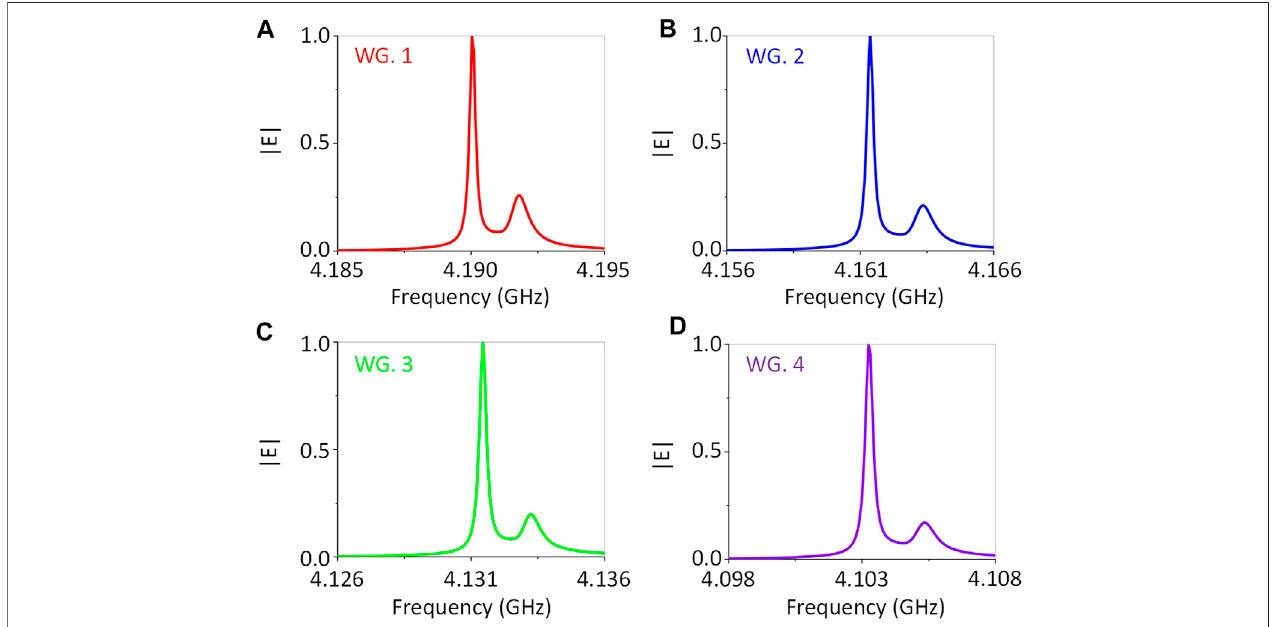
FIGURE 6 | Normalized electric fi eld intensity in the four types of waveguide segments at different frequencies. (A) WG. 1. (B) WG. 2. (C) WG. 3. (D) WG. 4. The intensity curves of WG. 1, WG. 2, WG. 3, and WG. 4 are marked in red, blue, green, and purple, respectively.